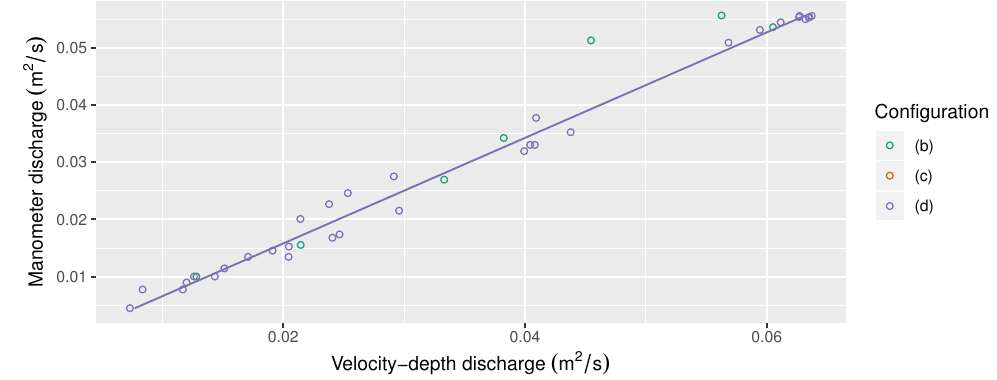
Figure 2. The relationship between velocity-depth and manometer discharges, with regression for